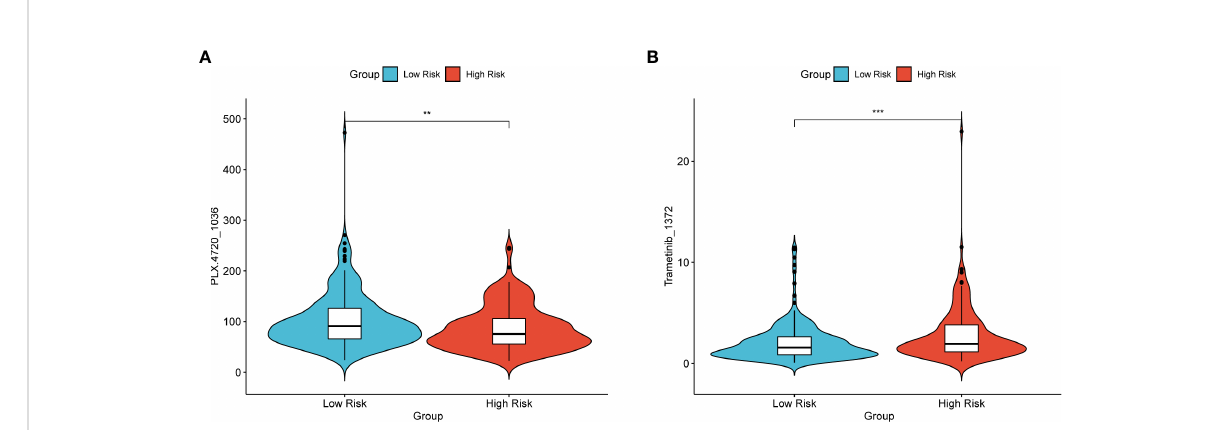
FIGURE 8 Violin plot of the IC50 of TCGA patients for the two drugs PLX.4720_1036 (A) and Trametinib_1372 (B) . The vertical axis represents the IC50 values, and the vertical axis is the high- and low-risk groups. *p< 0.05, **p< 0.01, ***p< 0.001, ****p< 0.0001, ns: not signi fi